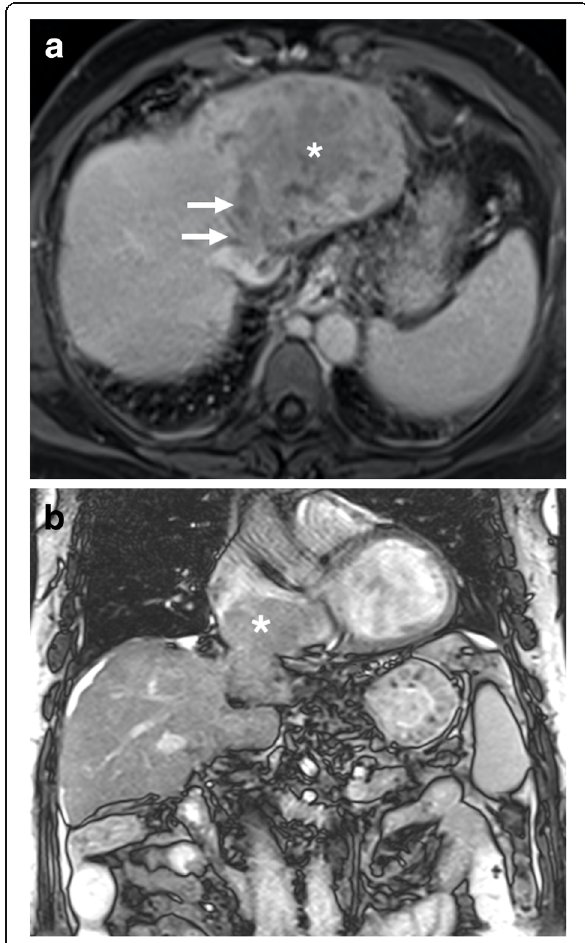
Fig. 5 A 60-year-old male with known hepatitis B-related chronic parenchymal liver disease now presents with abdominal pain, low